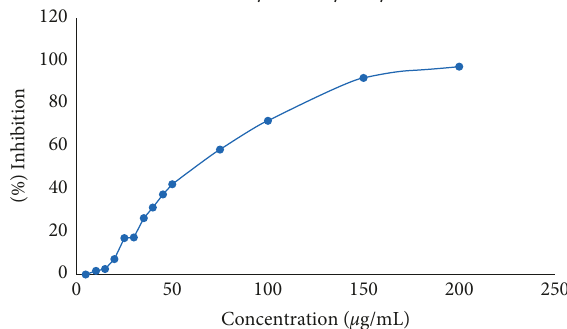
Figure 7: Cytotoxicity of SP-ZnONPs on A549 cell line. The lung cancer cells were treated with 5, 10, 15, 20, 25, 30, 35, 40, 45, 50, 55, 60, 75, 100, 150, and 200 μ g/mL concentrations of nanoparticles. MTT assay was performed to determine the toxicity of nanoparticles.